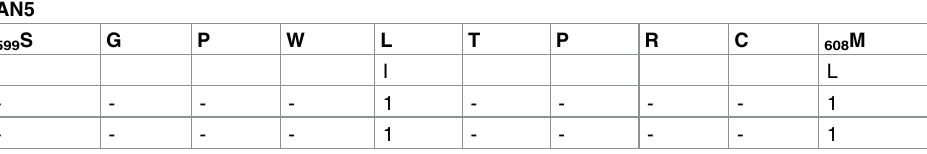
Table 9. Tolerance to the amino acid substitution in the epitopes targeted by VF-Fab3a-1-1. AN5 599 S G P W L T P R C 608 M I L - - - - 1 - - - - 1 - - - - 1 - - - - 1 Data presented is analysed and predicted using programme SIFT (http://sift.jcvi.org/www/SIFT_aligned_ seqs_submit.html). Row corresponds to a position in the reference epitope. Column corresponds to amino acid variation (observed in our data set) at that position in different HCVpp (Fig 4A). Score at a particular position for an amino acid substitution is mentioned below the amino acid variant. The default threshold for functional intolerance used was 0.05 for amino acid